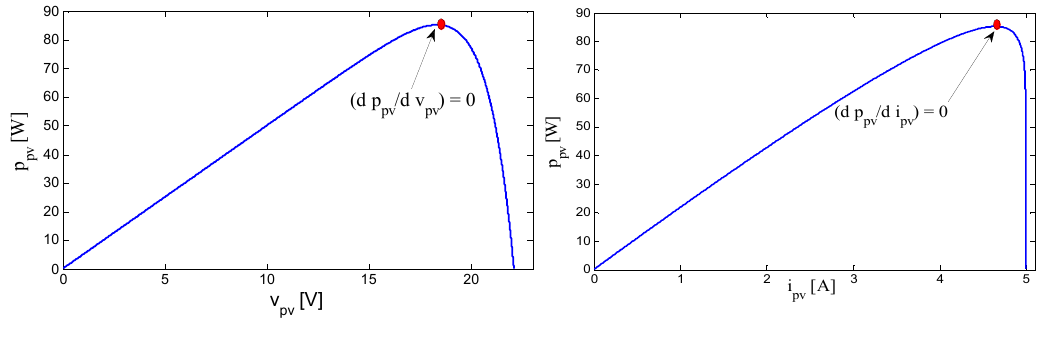
Figure 4. Power curves of a PV module.